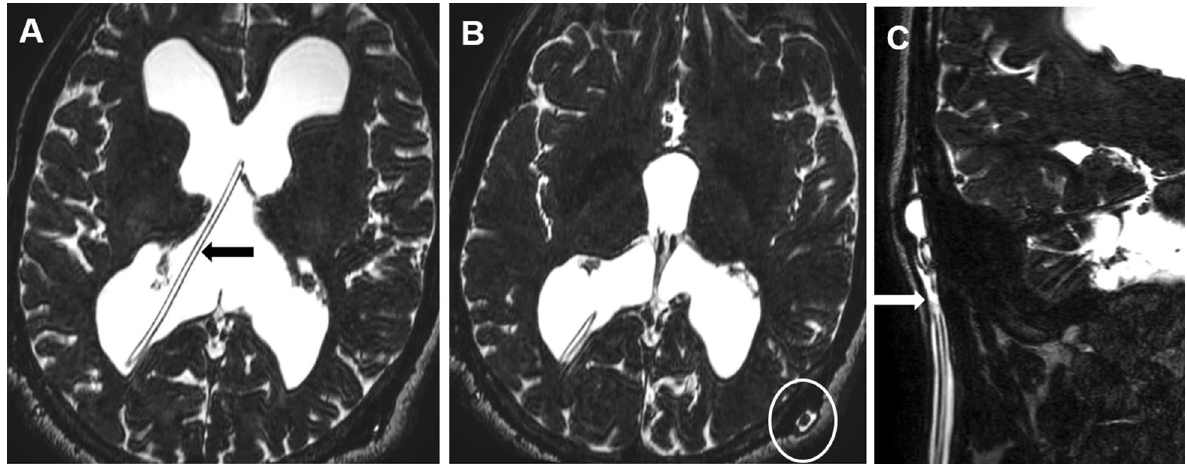
Fig. 8 A 27‑year‑old male patient presented with headache and blurring of vision. Reconstructed 3D‑DRIVE for the same patient who had 3 shunts, ( A , B ) in axial plane, showing collapsed reservoir (circle) with separated its proximal catheter (black arrow), ( C ) in coronal oblique, showing separated distal catheter from its valve with related fluid (white arrow); he had another right frontal shunt (non‑complicated, not shown)